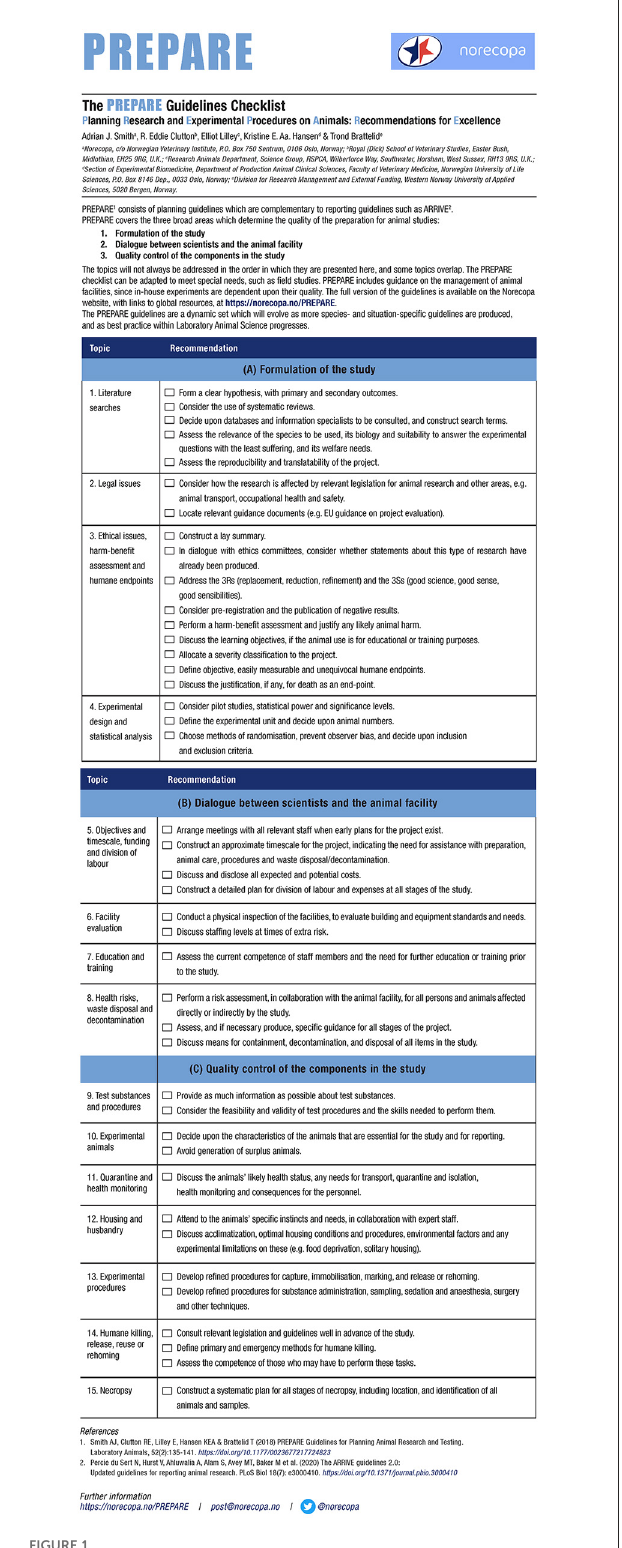
FIGURE1 The PREPARE checklist (https://norecopa.no/PREPARE/ prepare-checklist, accessed 8 January,